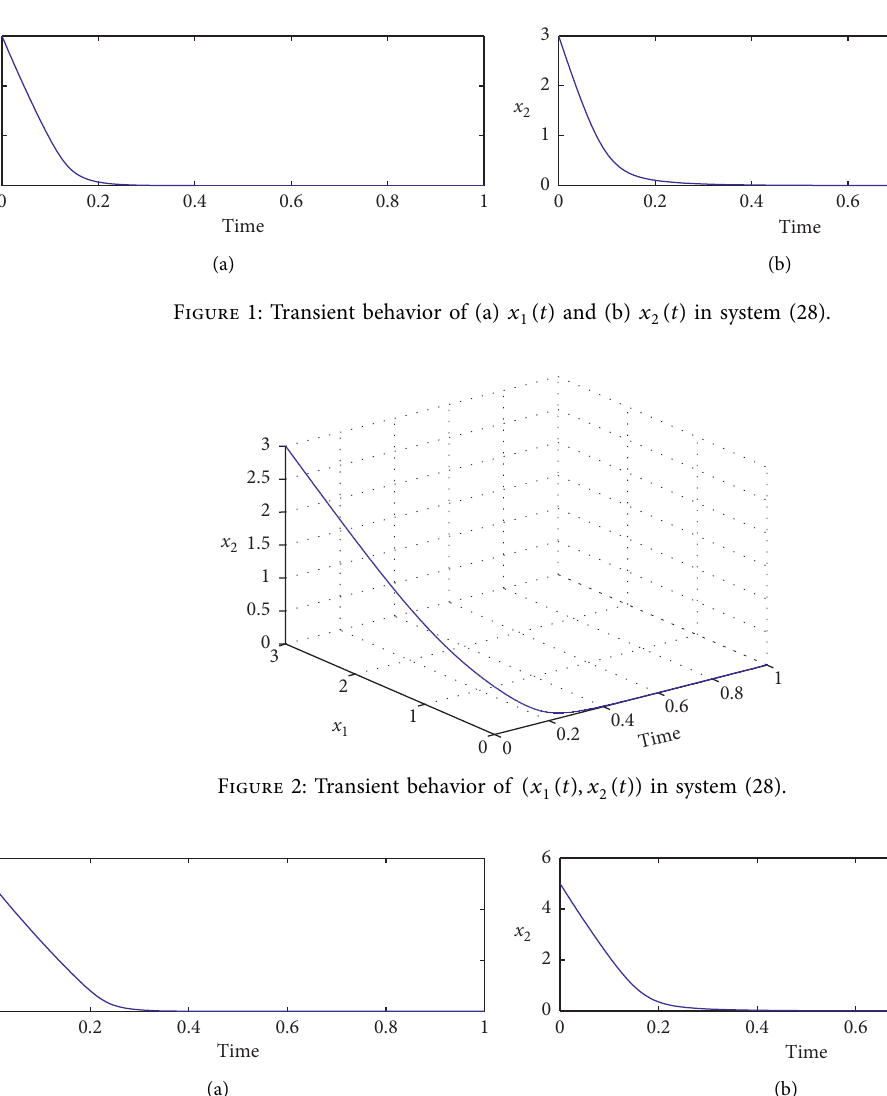
( t ) and (b) x ( t ) in system (31). 1 2